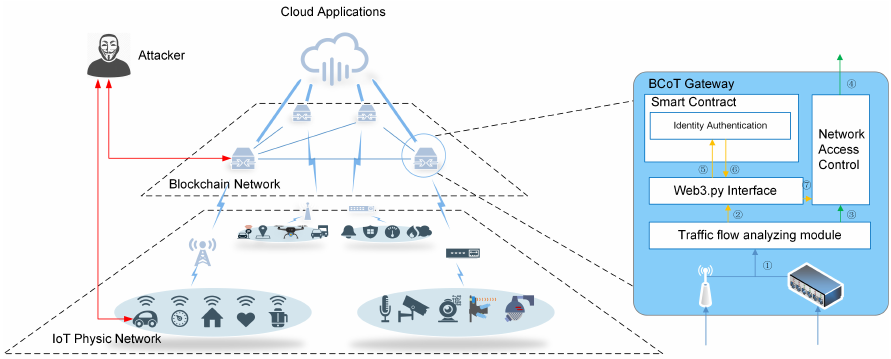
Figure 1. BCoT Sentry system